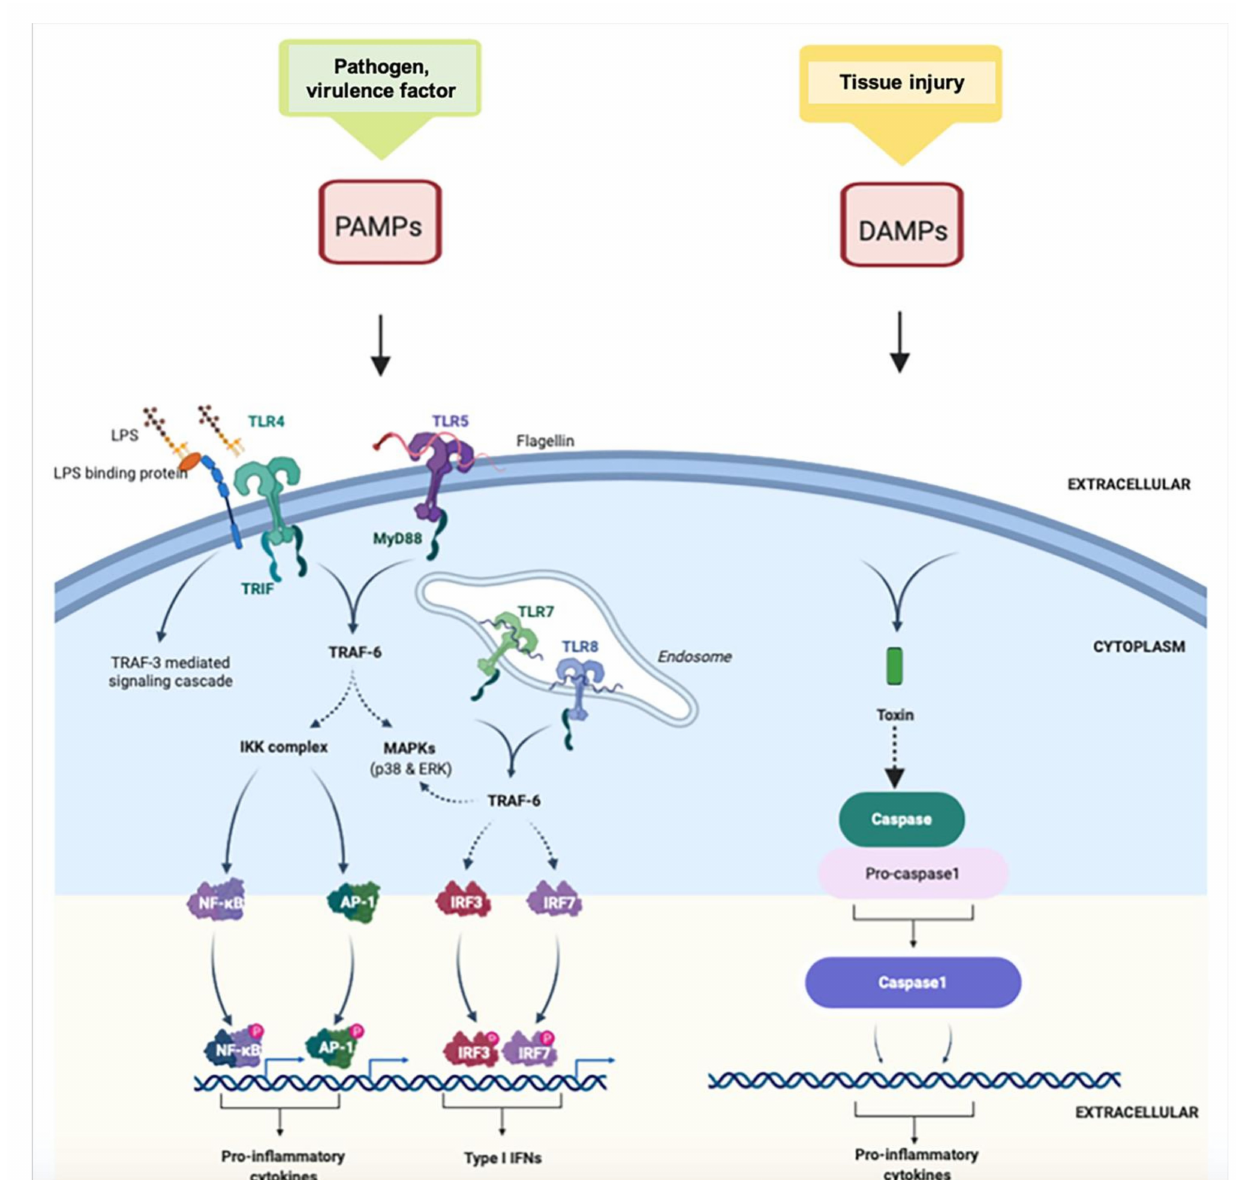
Figure 1. Regulation of inflammatory response. Dotted lines indicate presumable mechanisms, normal lines indicate known activation. PAMPs: molecular patterns associated with pathogens, DAMPs: molecular patterns associated with danger, LPS: Lipopolysaccharide, TRIF: TIR-domain-containing adapter-inducing interferon- β , TRAF: TNF receptor-associated factor, Myd88: Myeloid differentiation primary response 88, NF-kB: nuclear factor kappa-light-chain-enhancer of activated B cells, IKK: I κ B kinase, MAPK: mitogen-activated protein kinase, AP: Activator protein, IRF: Interferon regulatory